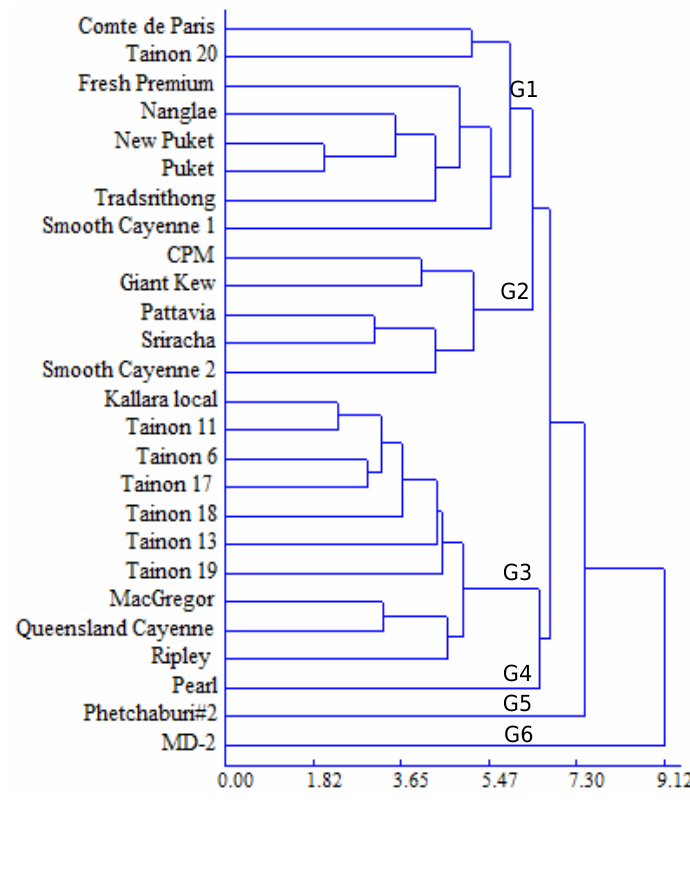
Figure 1. Dendrogram of 26 pineapple genotypes based on their physico-chemical composition and antioxidant